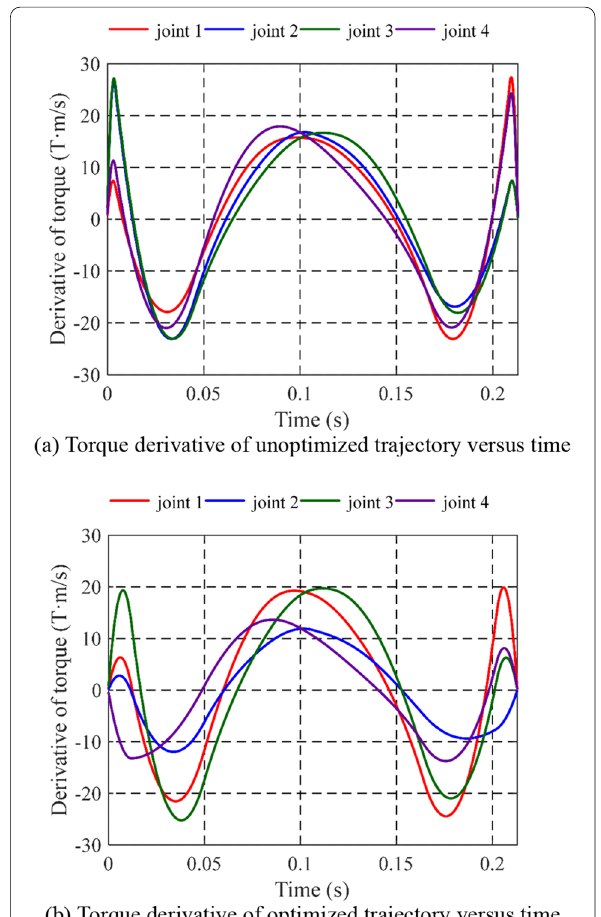
Figure 10 Torque derivative of unoptimized trajectory and optimized trajectory versus time